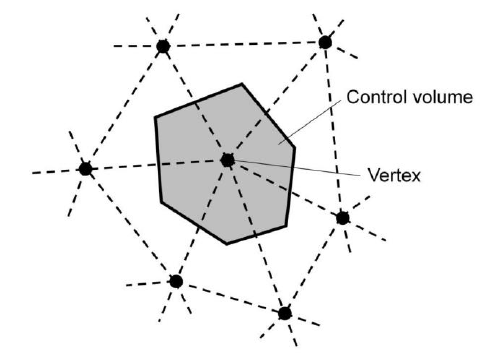
Fig. 1 Control body centered on the vertex.